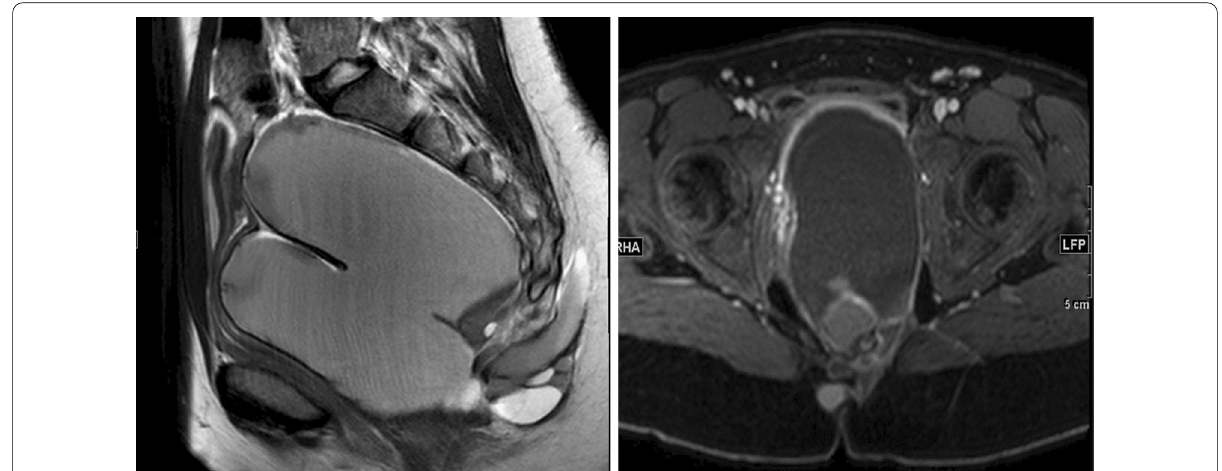
Fig. 1 Large multiloculated pre-sacral pelvic cystic lesion with small Sacrococcygeal extension causing mass effect,displacing the rectum to right side